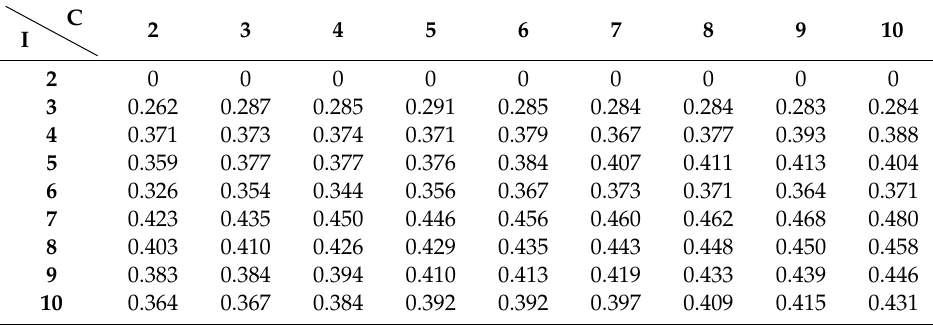
Figure 11. Results of performance index (PI) method for interval-based IGM (Case 1). Table 3. CCS prediction results for interval-based IGM (Case 2) using training data.